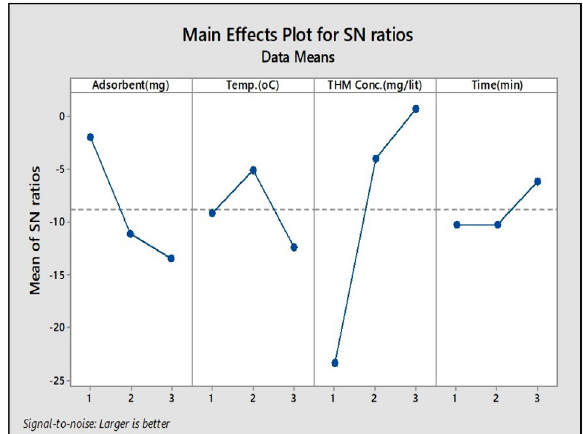
Figure 5. The results of the Taguchi design – adsorbent: 1= 10, 2 = 25, 3 = 50 mg; temperature: 1= 10, 2= 20, 3= 30 °C; the total concen- tration of THMs 1= 0.1, 2= 0.5 and 3 = 1 mg/L; and adsorption time: 1=10, 2= 60, 3=120 min. In each case the highest point indicates the optimum condition.